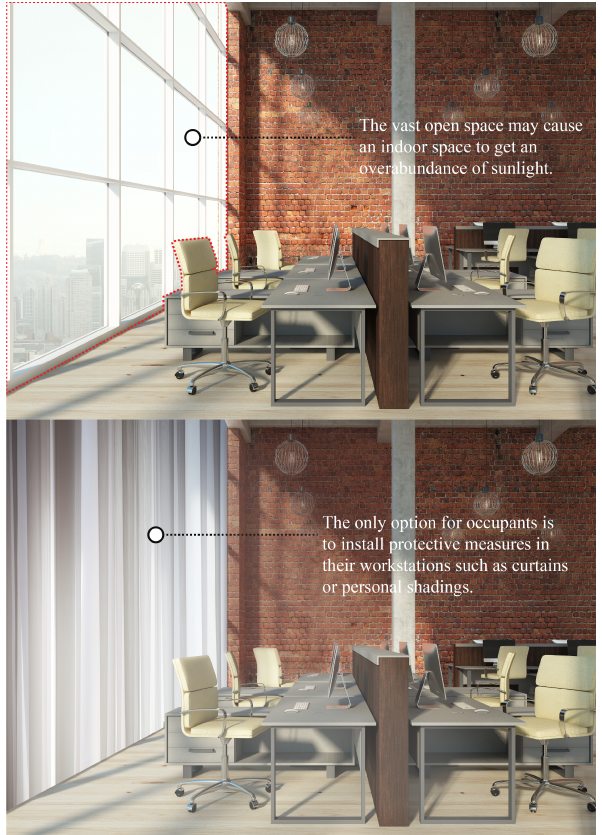
Figure 2. An over-glazed façade will cause excessive glare and overheating in interior spaces. The only option for occupants is to install protective measures in their